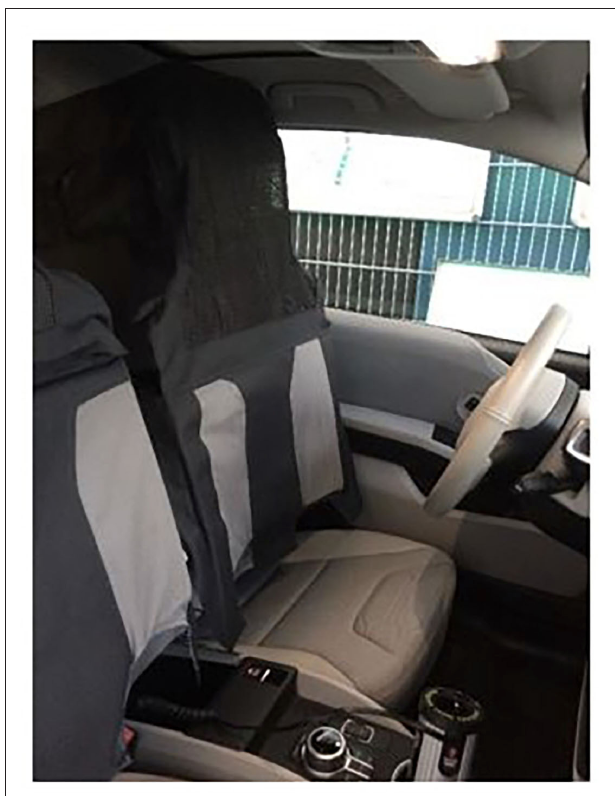
FIGURE 5 | The seat cover of a test vehicle to hide the driver and to simulate automated